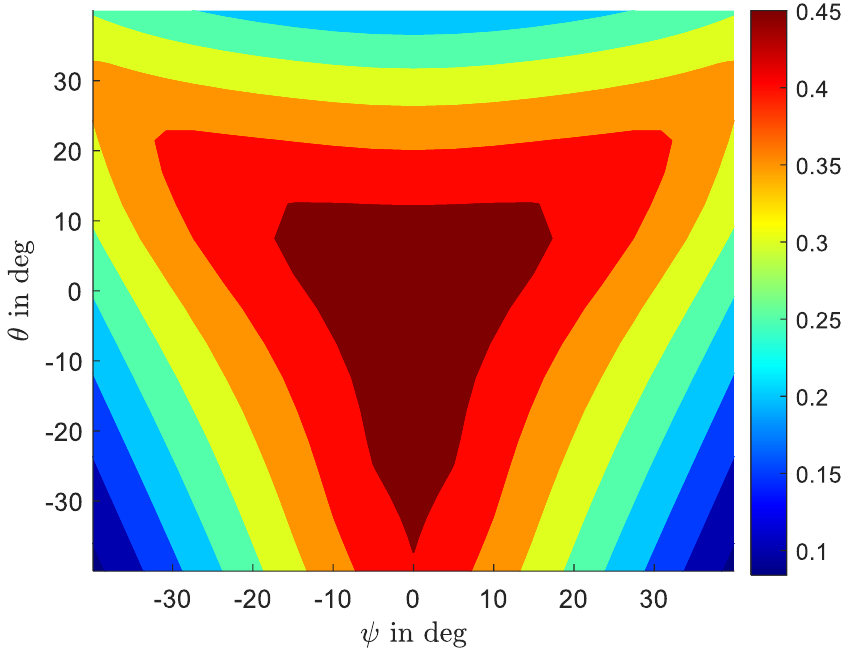
Figure 9. Manipulability of PhRS Figure 5c where parasitic motion along x-axis is